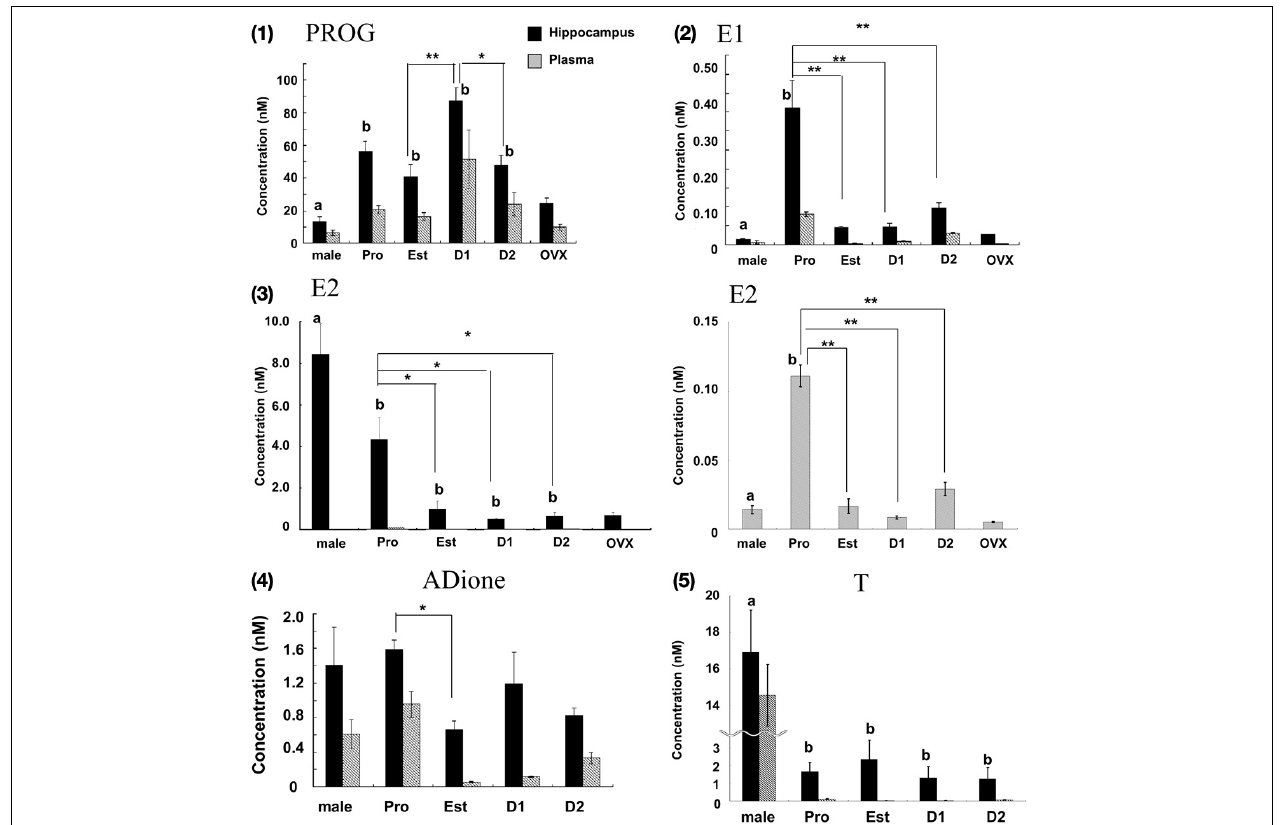
FIGURE 2 | Cyclic fluctuation of the levels of PROG (1), E1 (2), E2 (3), ADione (4), and T (5) in the female hippocampus and plasma. In each panel, from left to right, male hippocampus (male), female hippocampus at Pro (P), Est (E), D1 (D1), D2 (D2), and OVX female hippocampus (OVX). For comparison, male data are taken from Hojo et al. (2009). In panel (3), the magnified graph for plasma is also displayed, because the level of E2 in plasma was much lower than that in the hippocampus. For each estrous cycle stage measurement, 3–6 rats were used, and totally 16 rats were used. Four